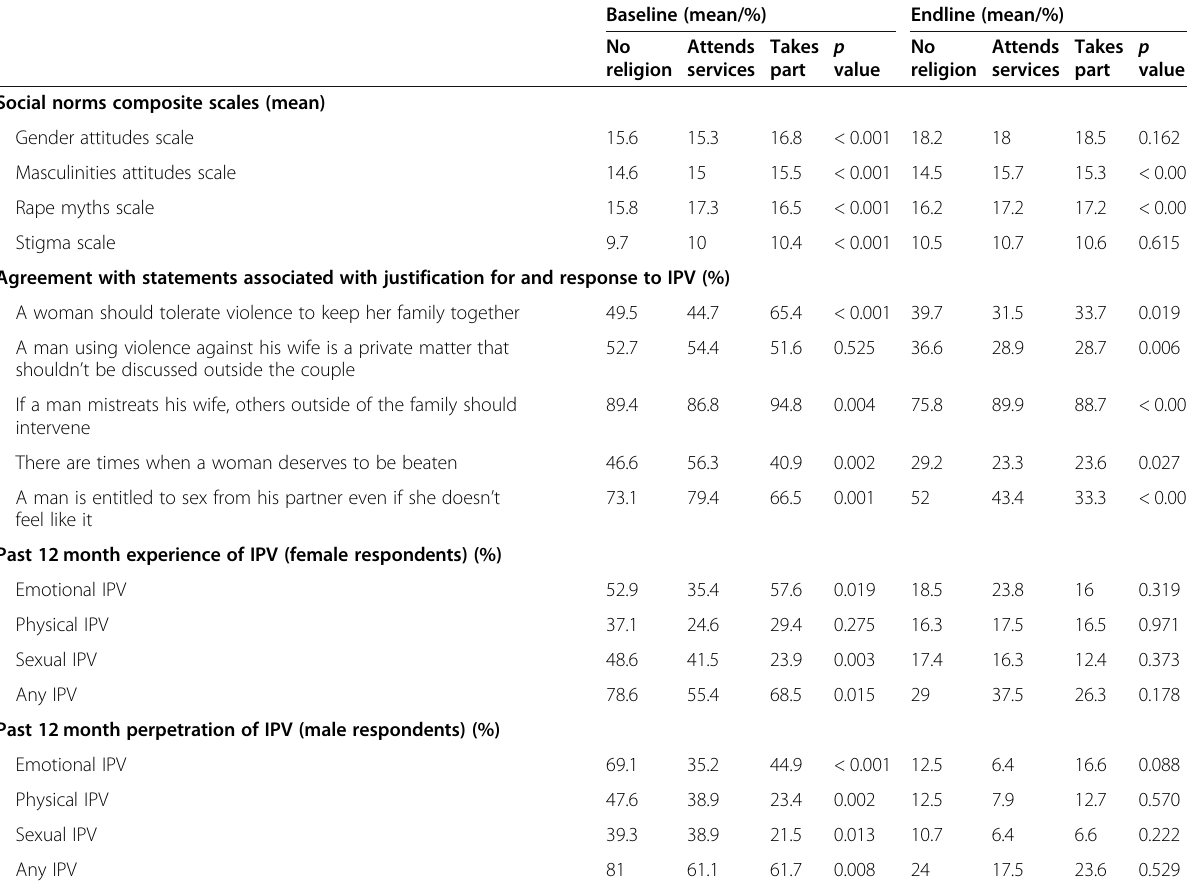
Table 7 Baseline and endline results for social norms, attitudes and experience and perpetration of IPV, disaggregated by faith engagement